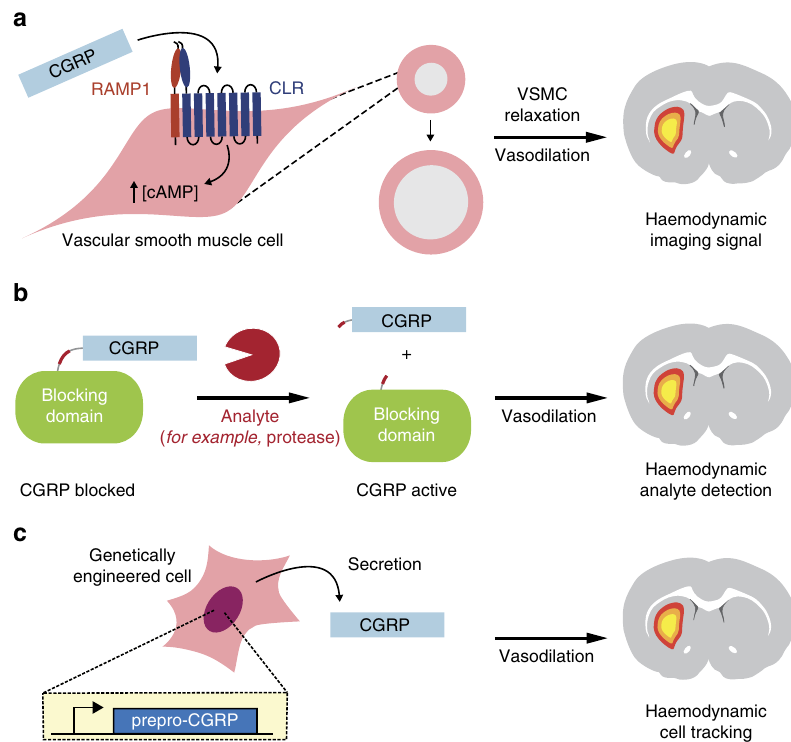
Figure 1 | Principle of molecular imaging with CGRP-induced haemodynamic responses. ( a ) CGRP acts on the heterodimeric G-protein coupled receptor RAMP1/CLR (left) to induce intracellular cAMP production, resulting in relaxation of vascular smooth muscle cells (VSMCs) and consequent vasodilation (middle). Dilation of microvasculature induces haemodynamic effects visible by MRI and other imaging methods (right). ( b ) Design for analyte-sensitive vasoactive probes comprising CGRP fused to a labile blocking domain via an analyte-responsive linker. Such probes can be activated by analytes that act sterically on the sensor to unblock the CGRP moiety, for example, by cleaving the blocking domain as shown here. This would induce an analyte-dependent haemodynamic response and enable molecular imaging with CGRP-based constructs. ( c ) Application of CGRP as a genetically encoded reporter would involve expressing prepro-CGRP in genetically modified cells or tissues. Subsequent processing of the construct should result in secreted CGRP, allowing the genetically modified cells to be tracked by haemodynamic imaging